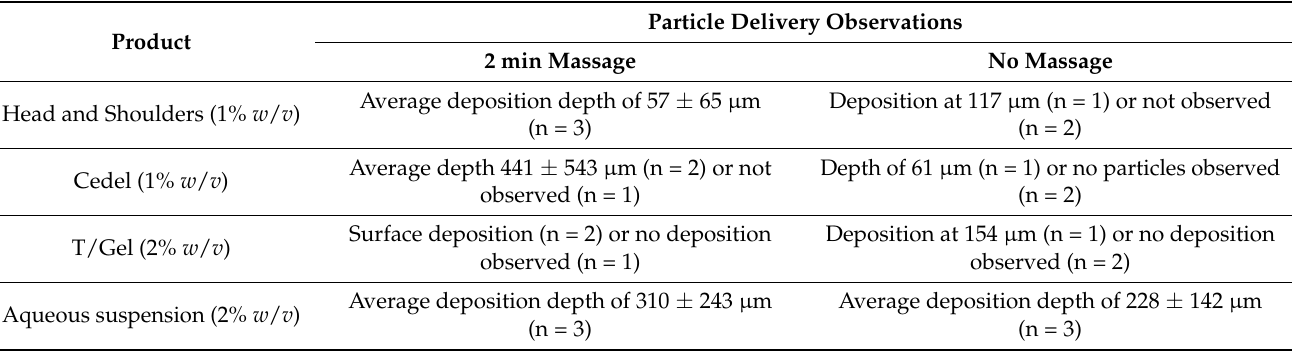
Table 1. Summary of findings from follicular delivery experiments.